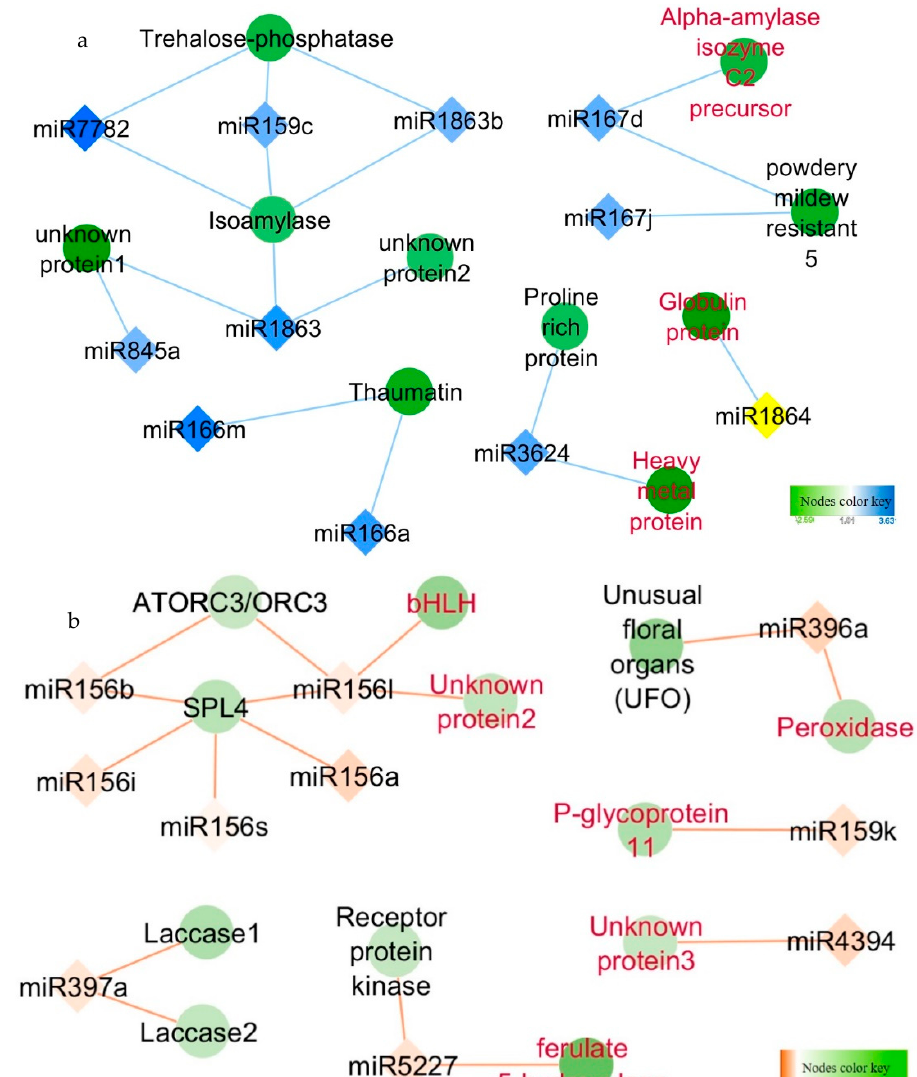
Figure 3. Example portions of miRNA-mediated ( a ) Stress networks for paradormant buds (LD, 15 h). ( b ) Meristem regulatory networks for endodormant buds (SD, 13 h). in V. riparia buds. Nodes are displayed for LD ( a , blue diamonds) and SD ( b , orange diamonds) abundant miRNAs, their target genes (green circle). The intensity of the node color is directly proportional to their expression. The complete networks of the inverse pattern of target genes are identified in Table S8. Genes identified in red font are genes that were noted to be downregulated in multiple dormancy studies (Table S8).